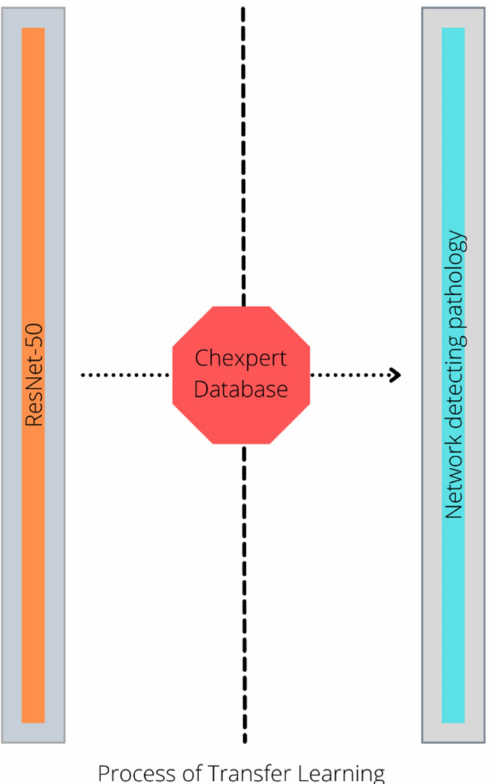
Figure 2. An explanation how new network was build using Transfer